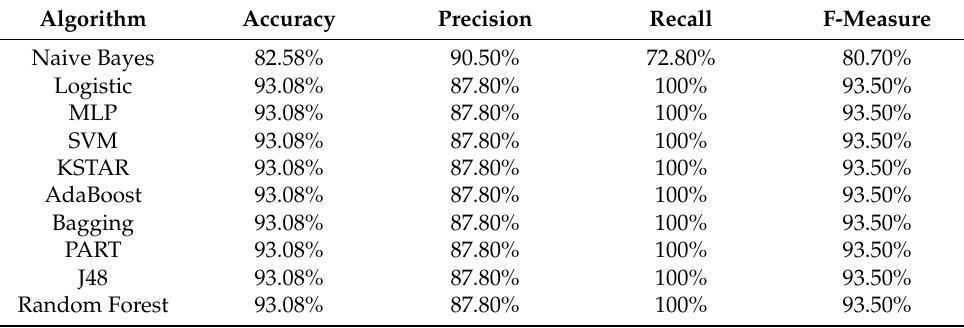
Table 2. Performance of the 10 classifiers on the red palm weevil (RPW) dataset.